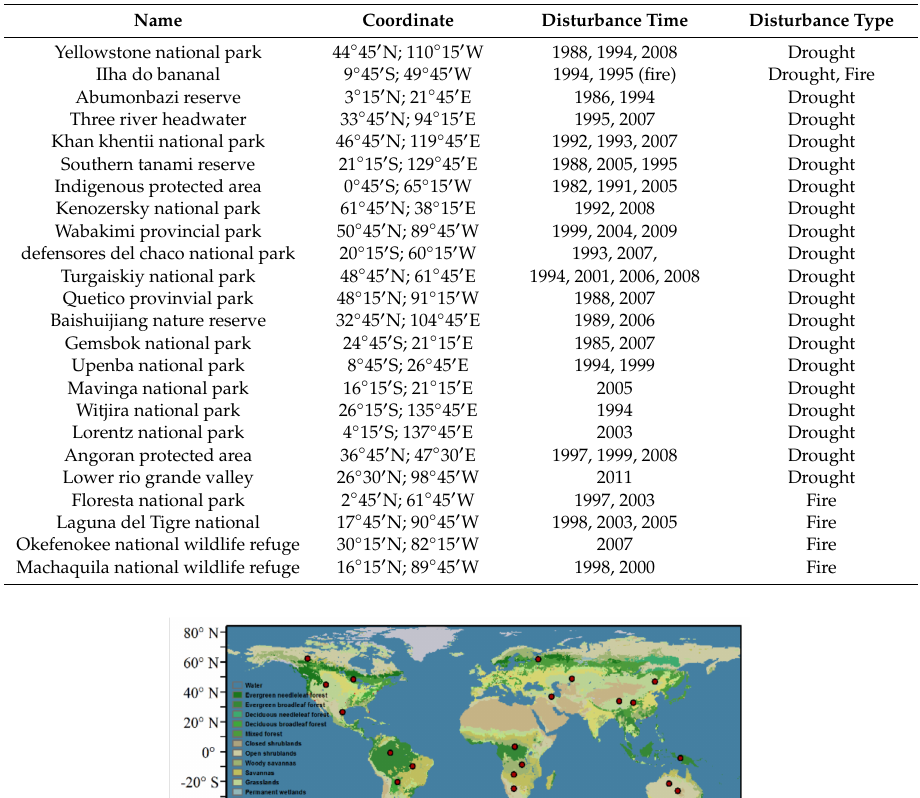
Table 2. The reference points.